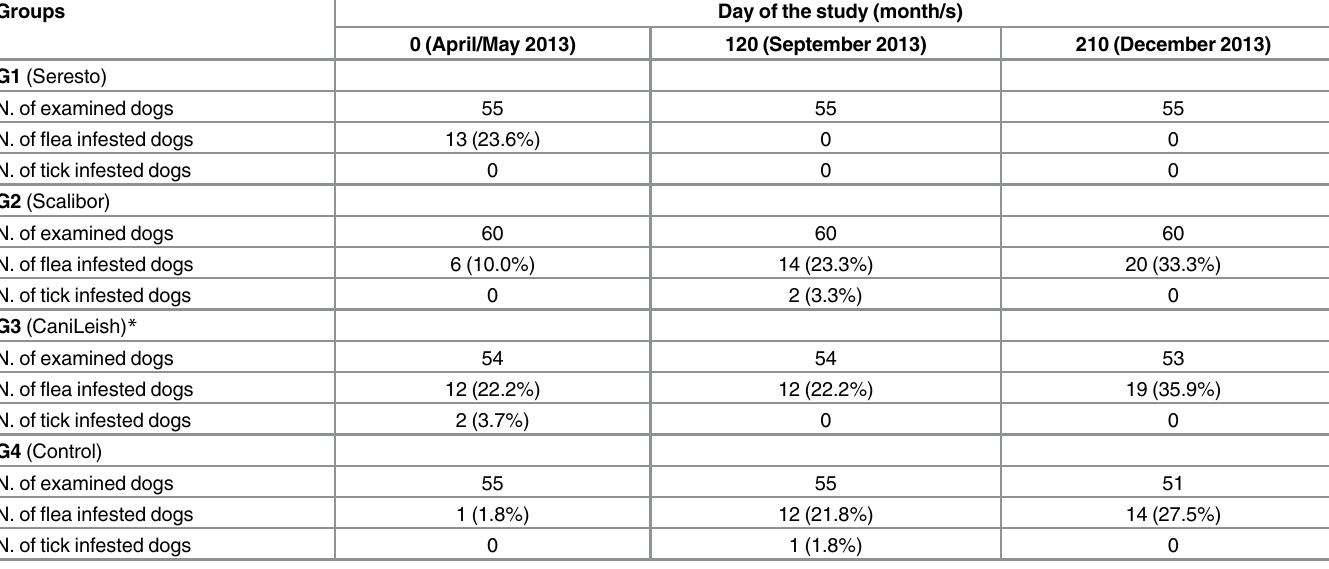
Table 1. Presence of flea and tick infestation at the different times of the study.